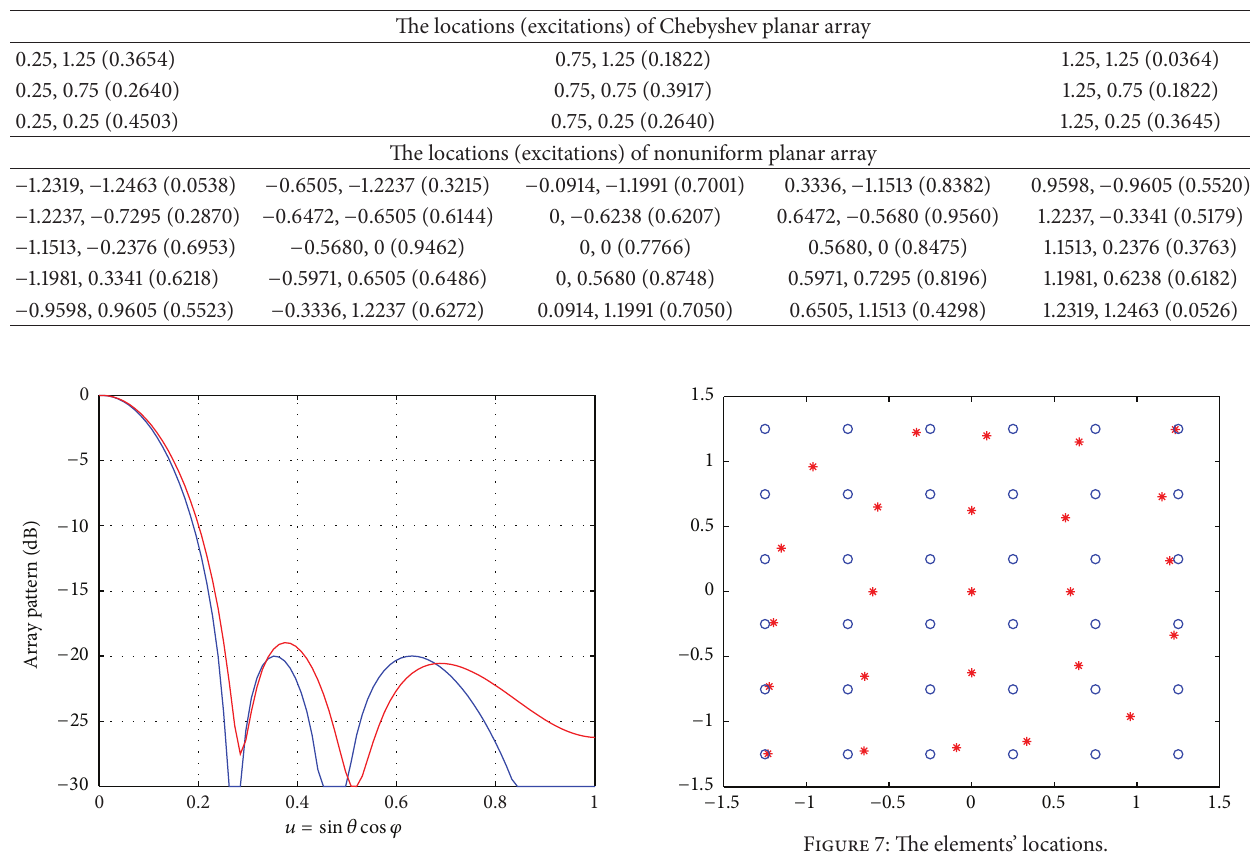
Table 2: The locations (excitations) of Chebyshev and nonuniformly spaced array.